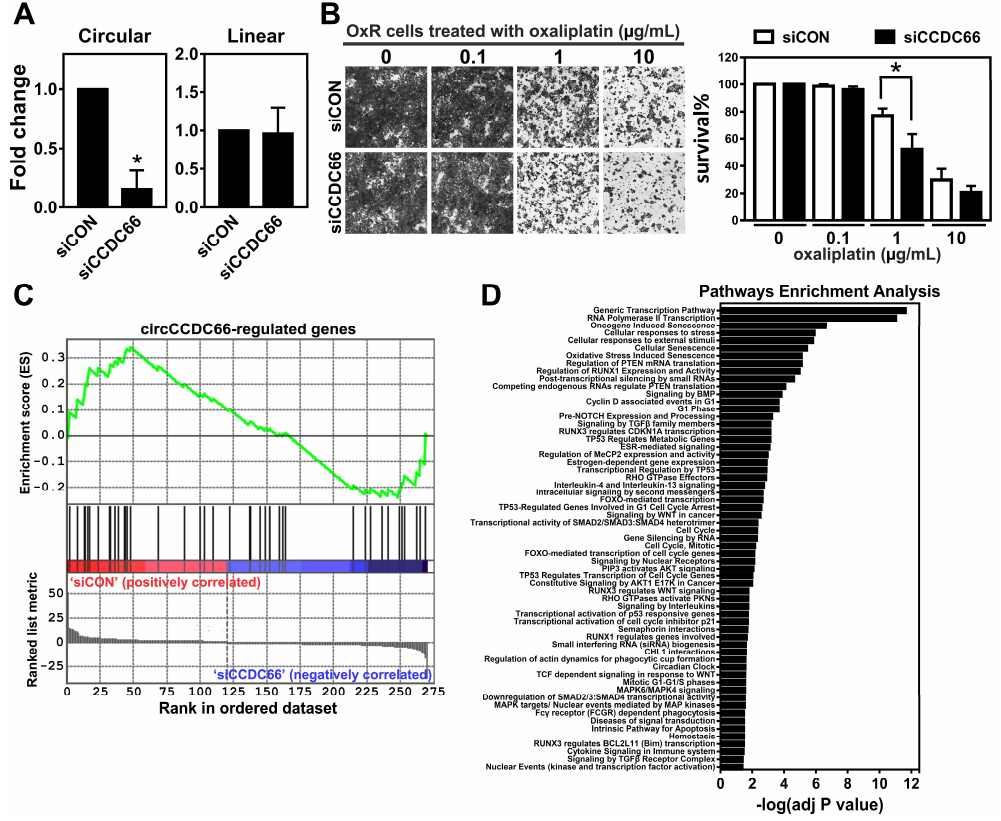
Figure 2. The expression of circCCDC66 is required for cell survival under oxaliplatin-induced genotoxic stress. ( A ) The levels of the circular transcript and mRNA (linear transcript) of CCDC66 assessed by qPCR in HCT116 transfected with control siRNA (siCON) or siRNA against circCCDC66 (siCCDC66). ( B ) The results of Coomassie blue staining from oxaliplatin-resistant (OxR) HCT116 transfected with control siRNA (siCON) or siRNA against circCCDC66 (siCCDC66) followed by a treatment with oxaliplatin at indicated concentrations for 48 h. Right panel: Quantitative results from the Coomassie blue staining. ( C ) Result of Gene Set Enrichment Analysis using the gene list ranked by fold change (siCCDC66/siCON) and circCCDC66 target genes. ( D ) Result of a pathway enrichment analysis using circCCDC66 target genes. * p < 0.05.